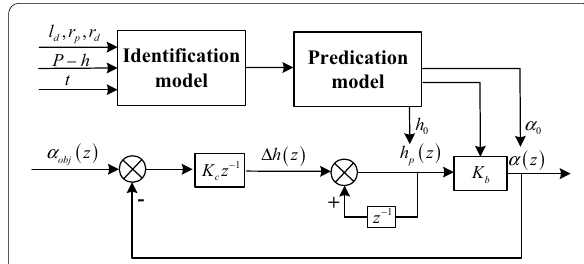
Figure 12 Control system flow chart